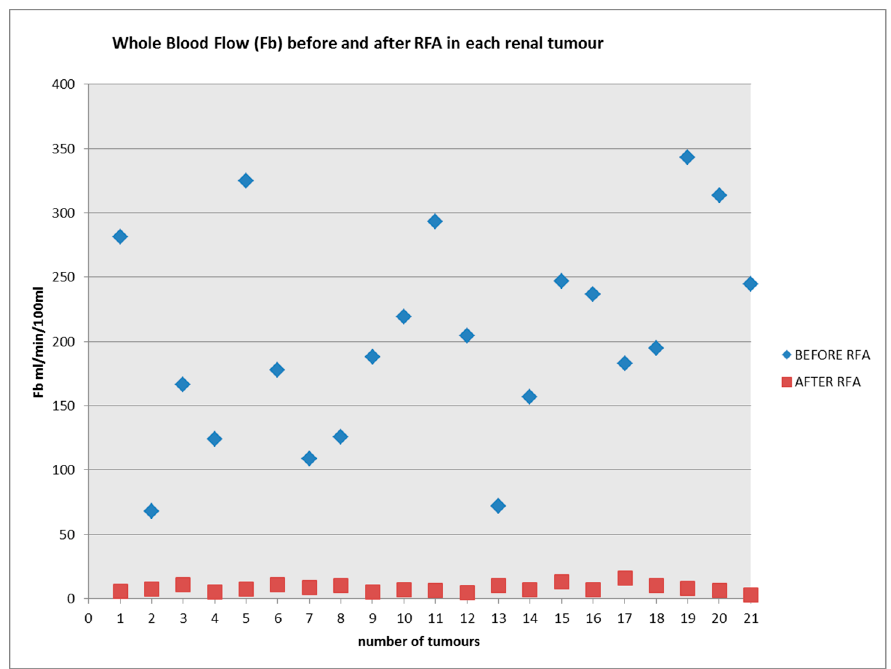
Figure 7. The scatter plot for blood flow in each renal tumour before and after RFA treatment.